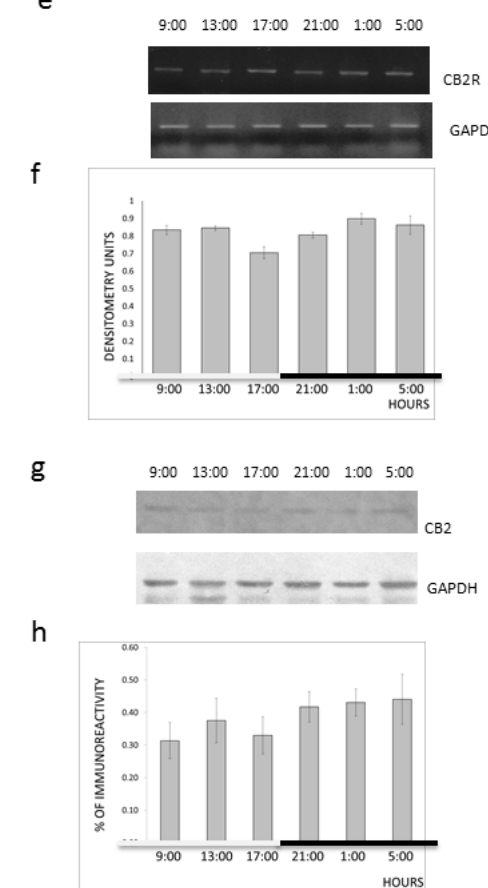
Figure 2. Effect of light-dark cycle on CB1R and CB2R expression. ( a ) Representative ethidium bromide-stained gel of polymerase chain reaction (PCR) fragments of CB1R and glyceraldehyde-3-phosphate dehydrogenase (GAPDH) in the rat cerebral cortex at different hours of the day; ( b ) Quantification of a negative ethidium bromide-stained gel by densitometry. The bars represent the mean ± SEM of the ratio of the densitometry units for CB1R and GAPDH ( n = 4). The bars with the same letter were not significantly different in a one-way ANOVA and a Duncan post-hoc ; ( c ) Representative picture of a western immunoblot of CB1R and GAPDH in the rat cerebral cortex at different hours of the day; ( d ) Quantification by densitometry of the western immunoblot bands. The bars represent the mean ± SEM of the ratio of the densitometry for CB1R and GAPDH ( n = 4); * p < 0.05. One-way ANOVA and a Duncan post-hoc test; ( e ) Representative ethidium bromide-stained gel of PCR fragments of CB2R and GAPDH in the rat cerebral cortex at different hours of the day; ( f ) Quantification by densitometry of a negative ethidium bromide-stained gel. The bars represent the mean ± SEM of the ratio of the densitometry units for CB2R and GAPDH ( n = 4); ( g ) Representative picture of a western immunoblot for CB2R and GAPDH in the rat cerebral cortex at different hours of the day; ( h ) Quantification by densitometry of the western immunoblot bands. The bars represent the mean ± SEM of the ratio of the densitometry obtained for CB2R and GAPDH ( n = 4); p < 0.05. One-way ANOVA and a Duncan post-hoc